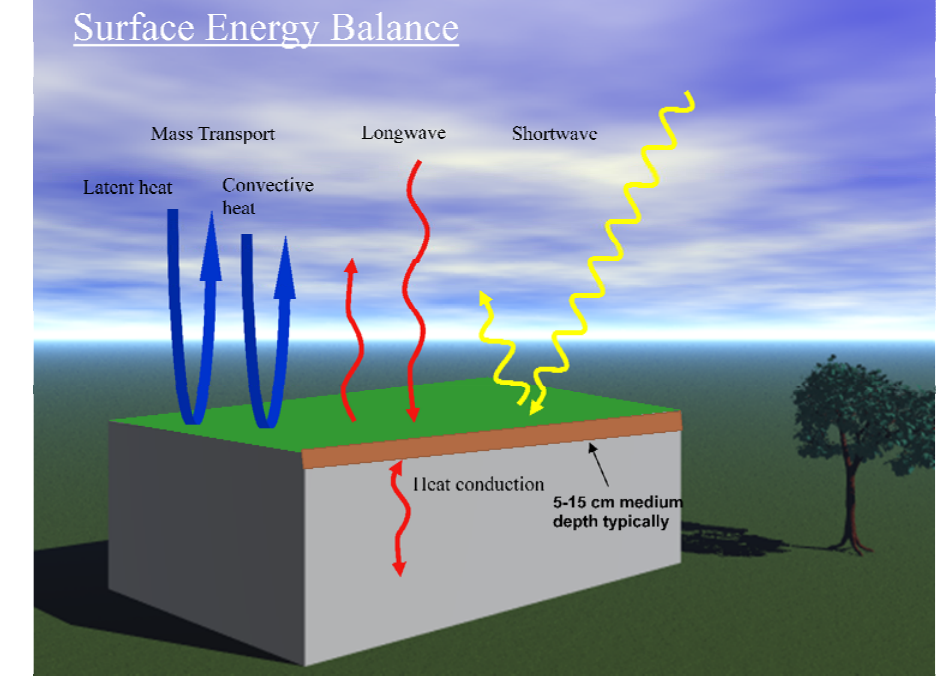
Figure 3. Simplified surface energy balance diagram for a green roof illustrating the major energy fluxes that need to be measured or